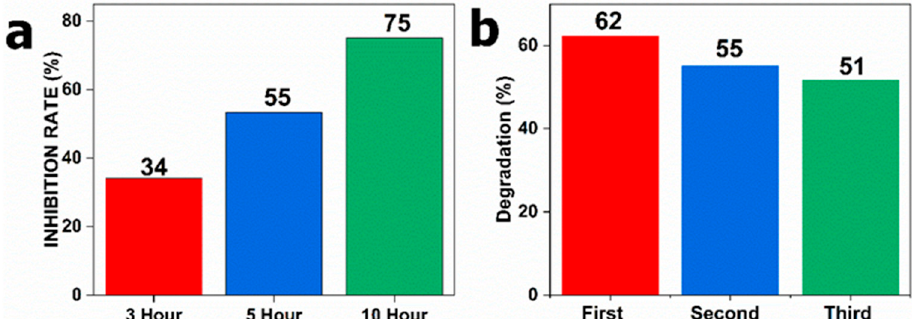
Figure 14. TOC removal during photocatalysis of DCF over CNQD-6 ( a ), and removal of DCF by CNQD-6 in three consecutive cycles ( b ).